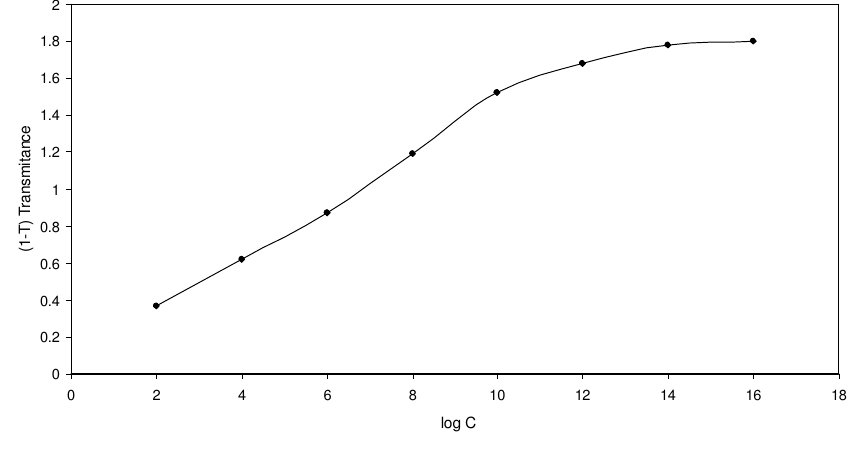
Figure 2 . Ringboom’s plot of carbofuran+4,4-azo bis-3,3’5,5’-tetra bromoaniline